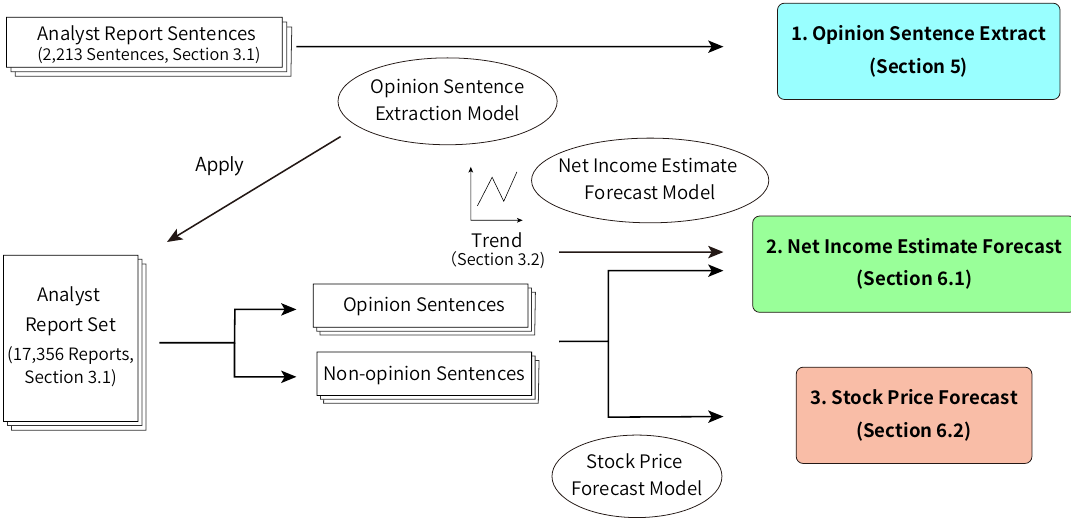
Figure 1. Flow of experiments in this paper. This paper focuses on three experiments: opinion sentence extract, net income estimate forecast, and stock price forecast. The opinion sentence extraction is conducted as a